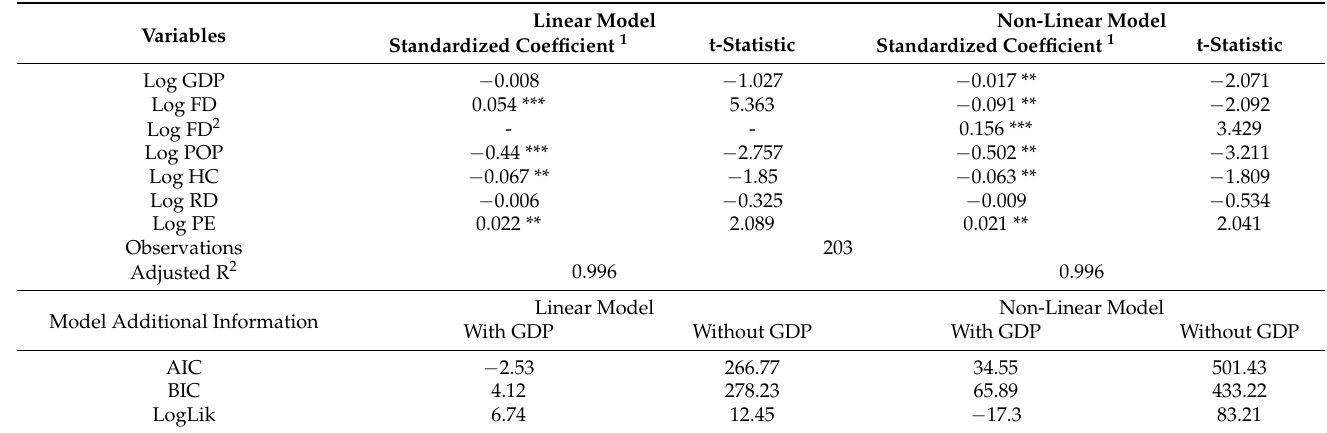
Table 5. Panel data-fixed effect regression results. Dependent variable: GHG.